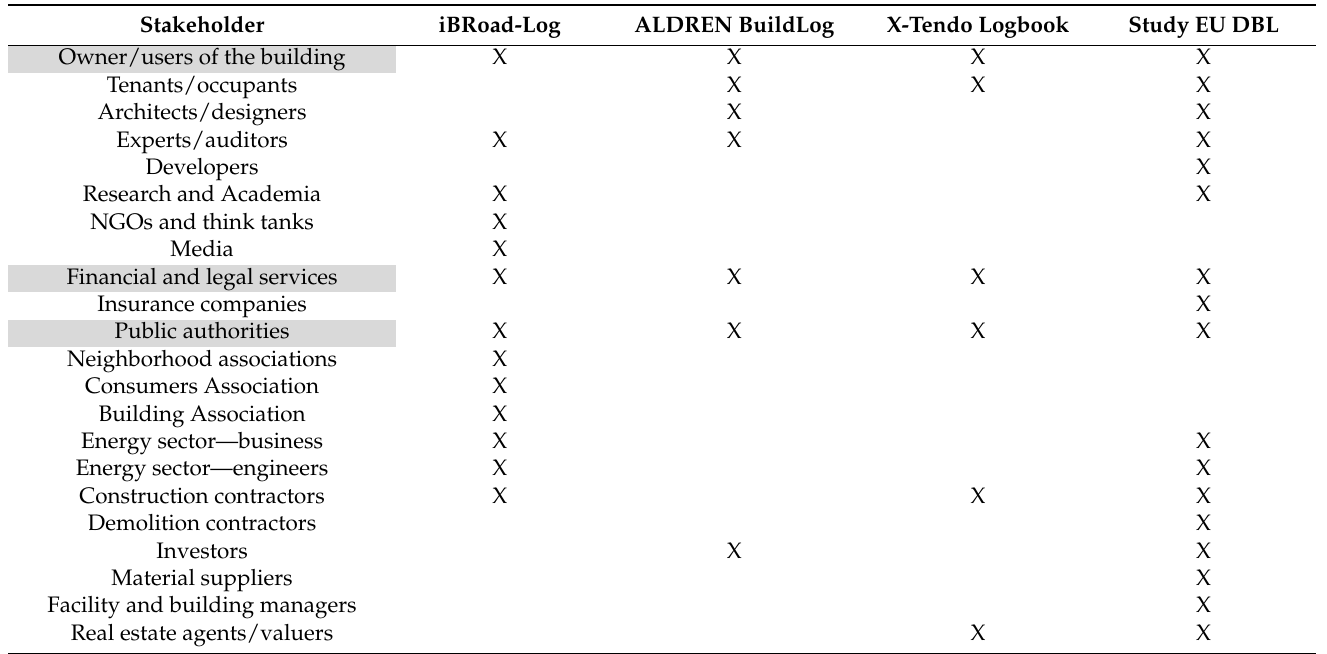
Table 4. Stakeholders considered in each DBL proposal. The most important agents, identified by all the DBL initiatives, are highlighted